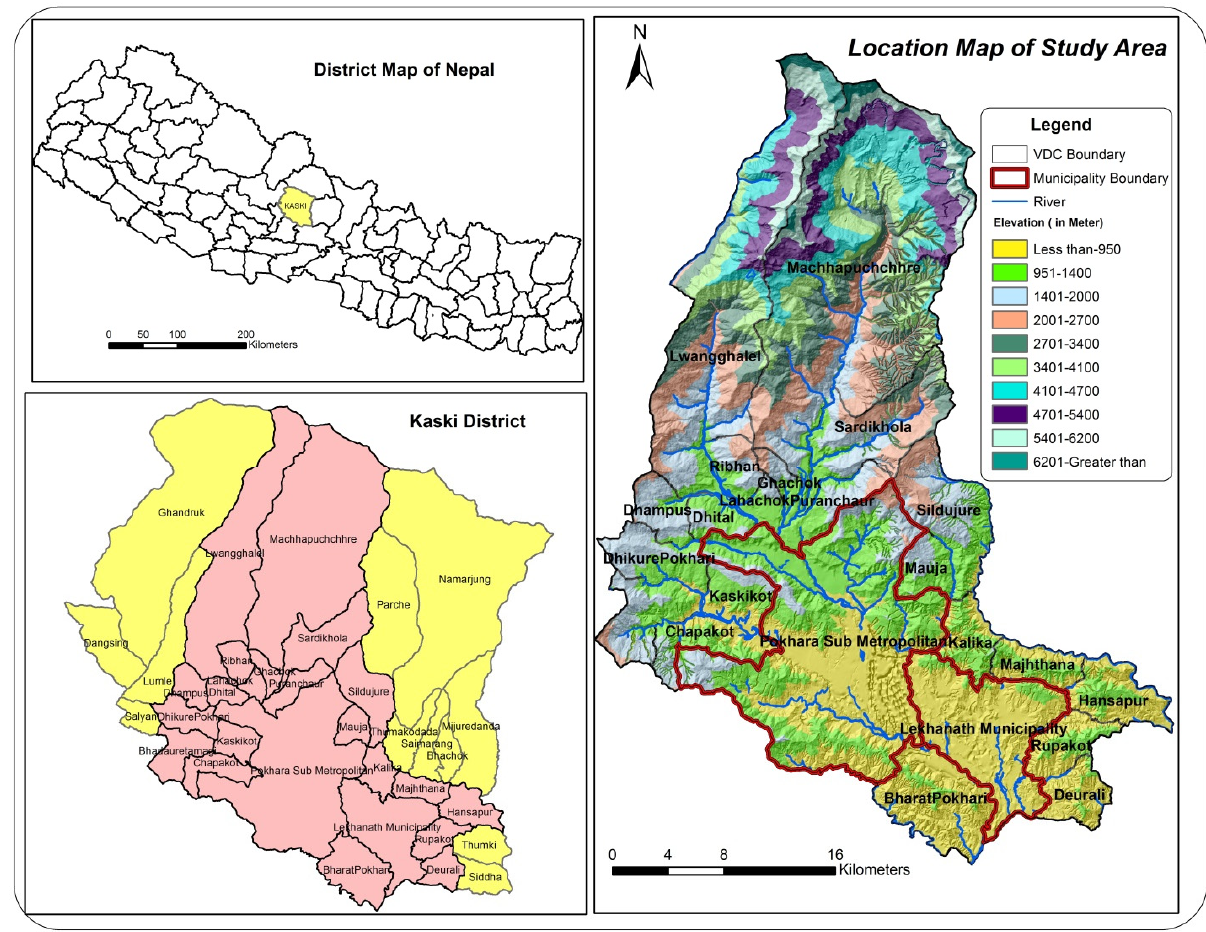
Figure 1. Location map of the study